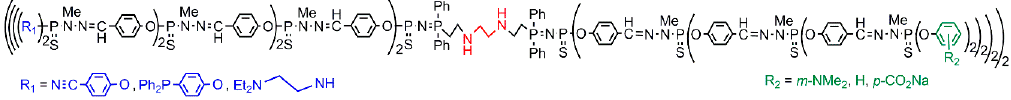
Figure 8. Examples of Janus dendrimers obtained by the association of two dendrons with a